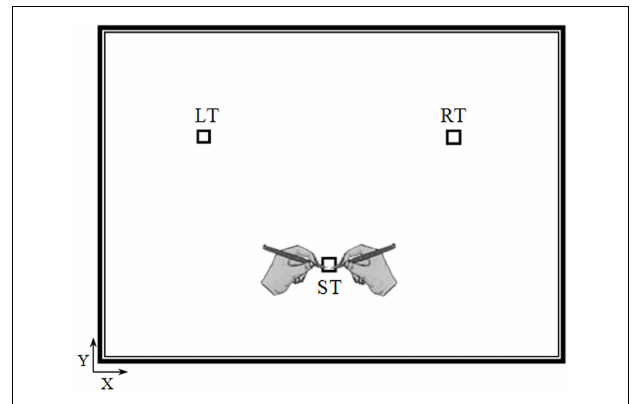
FIGURE 1 |Top view of the experimental device . Elderly and young participants performed actual and mental pointing movements between the three targets with their right or left arm.The distance and the angle between the starting target (ST) and the other two targets (the right target, RT and the left target, LT) were 20cm and 90°,